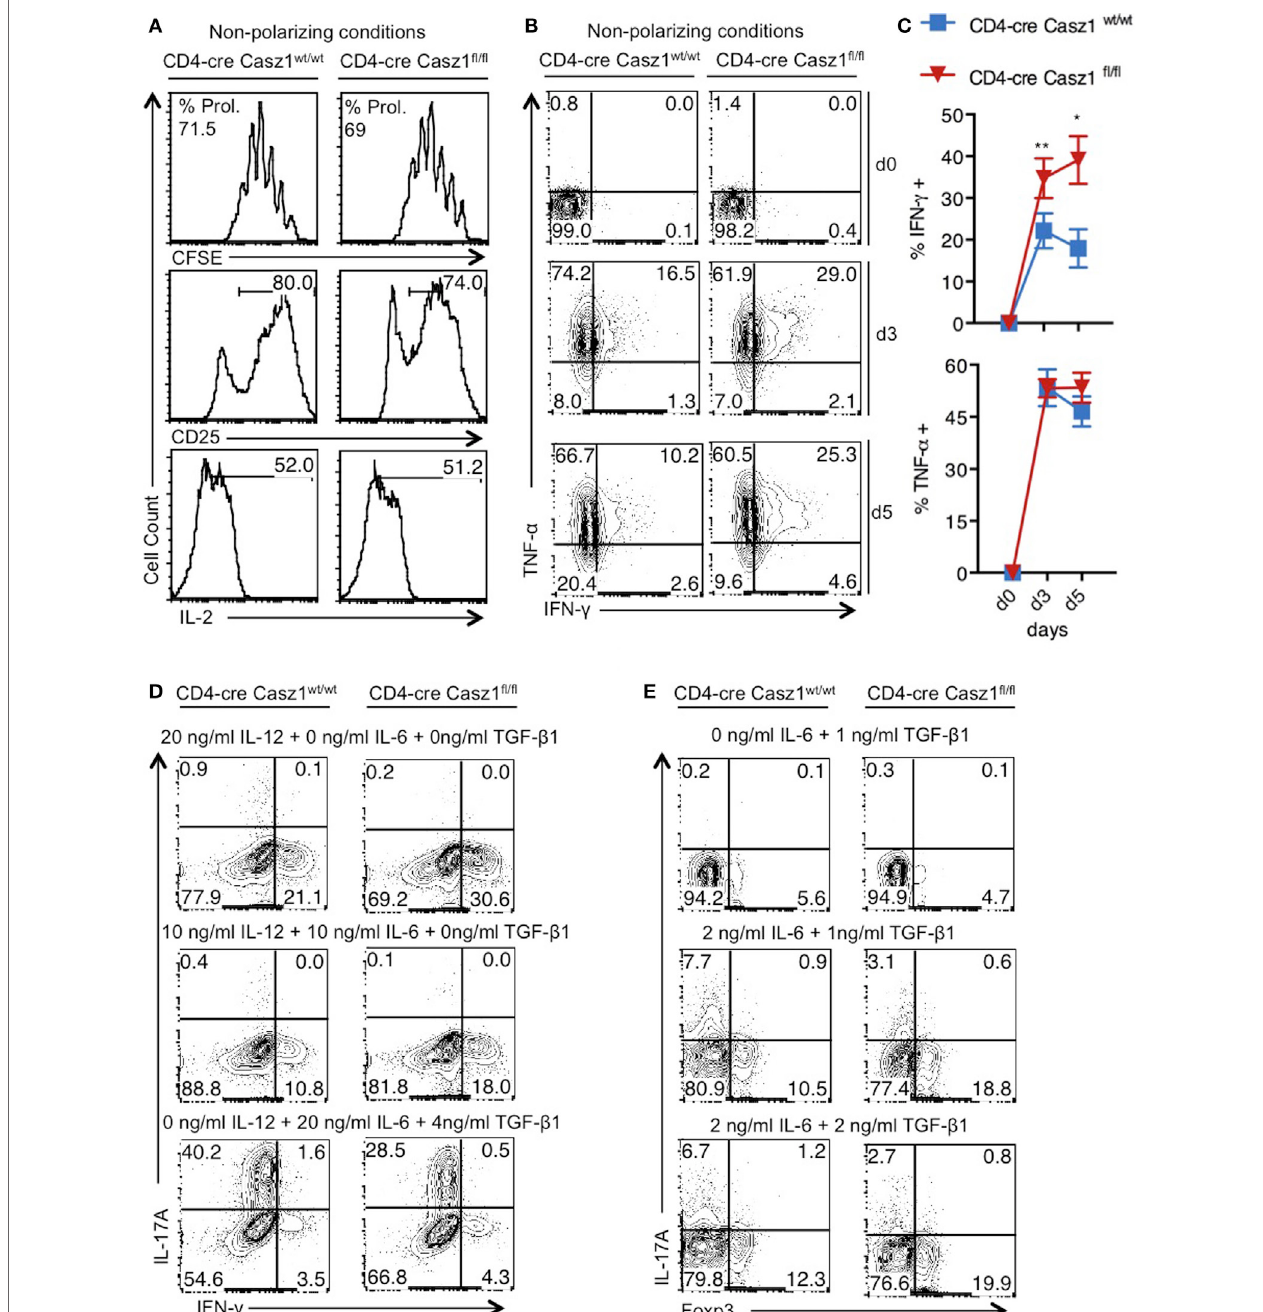
FigUre 2 | Casz1 controls T helper lineage differentiation depending on the cytokine milieu. (a–c) Naïve CD4 + cells isolated from WT (left) or knockout (right) mice were stimulated with 1 µg/ml of plate-bound α -CD3 and 2 µg/ml of soluble α -CD28 antibodies for 4 days (a,B) or for indicated times and subjected to flow cytometry. The percentage of divided cells is indicated as % Prol. in (a) . (c) Averages from 3 independent experiments are plotted. * P < 0.05, as determined by unpaired Student’s t -test. (D,e) Cells were stimulated as in (a) , in the presence of indicated cytokines for 4 days before the intracellular staining and flow cytometry. Data represent one of the five independent experiments showing similar results. Gates were drawn using unstain or isotype